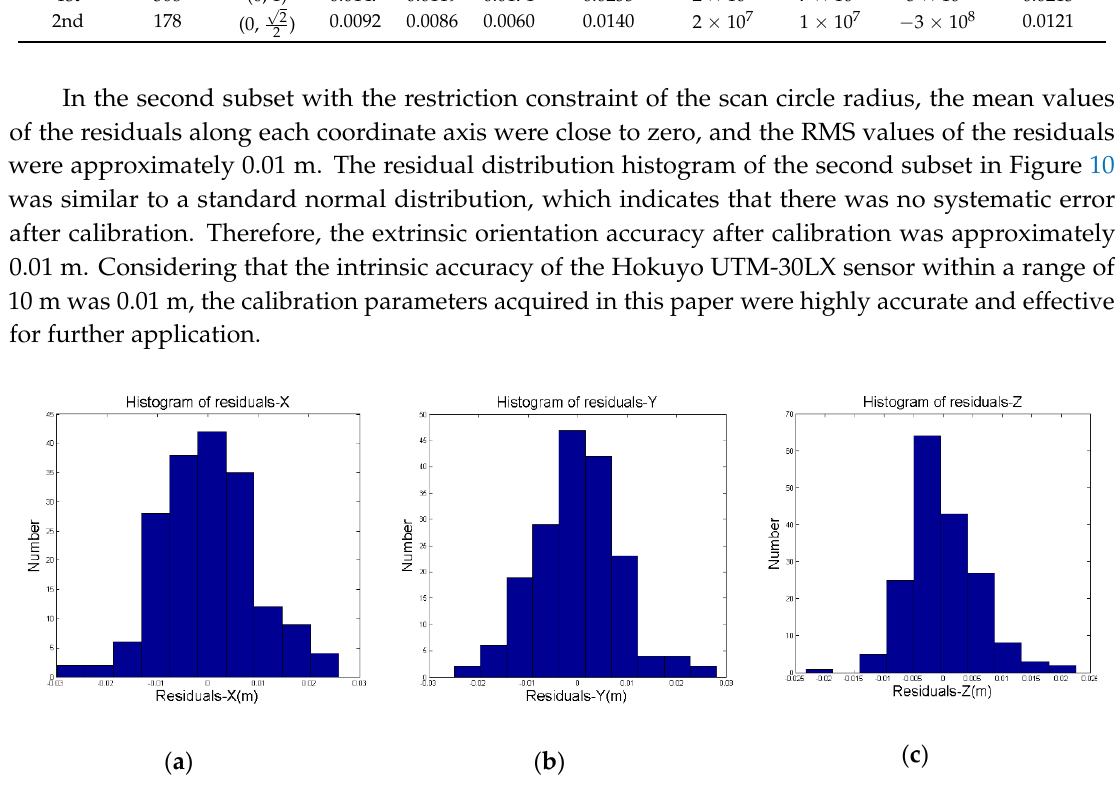
Table 3. Orientation accuracies in the two subsets of dataset1. The RMS of the Euclidean metric equals the absolute mean error in Table 2. The mean of the Euclidean metric equals the standard deviation in Table 2.